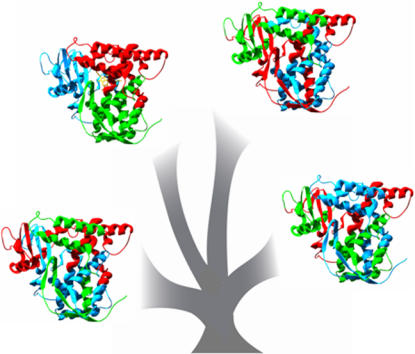
The creation of an artificial family of thousands of new proteins by shuffling protein building blocks allows us to probe protein structure and function, free from the filtering effects of natural selection.